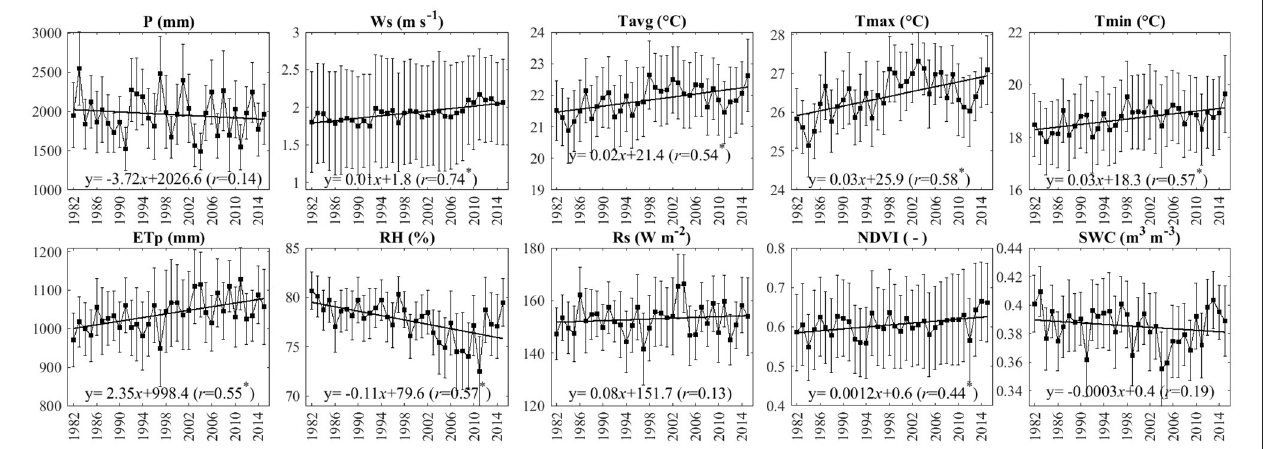
FIGURE 2 | Annual variations of precipitation (P), wind speed (W s ), mean, maximum, minimum temperature (T avg , T max , T min ), relative humidity (RH), solar radiation (R